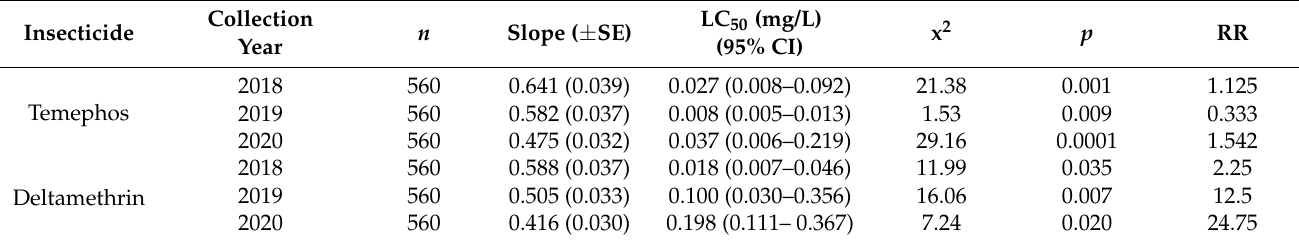
Table 1. Temephos and deltamethrin sensitivity of BUK Ae. aegypti larvae.